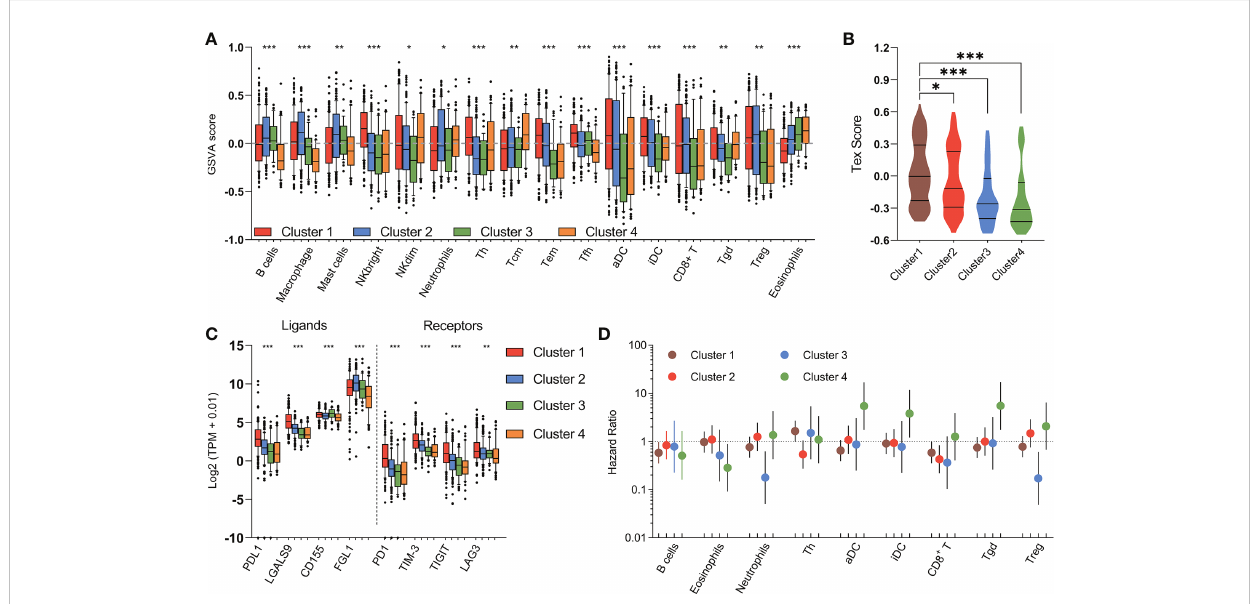
FIGURE 6 Immune characteristics of metabolic subtypes. (A) Box plots depicting the abundance of immune cell populations in each subgroup. (B) Violin plots showing the distribution of T cell exhaustion scores (Tex Score) in samples of each group. (C) Box plots depicting the expression of immune checkpoints across metabolic subtypes. (D) The prognostic signi fi cance of the abundance of each immune cell population in each subtype are summarized in a forest plot. (*P < 0.05, **P < 0.01, ***P <